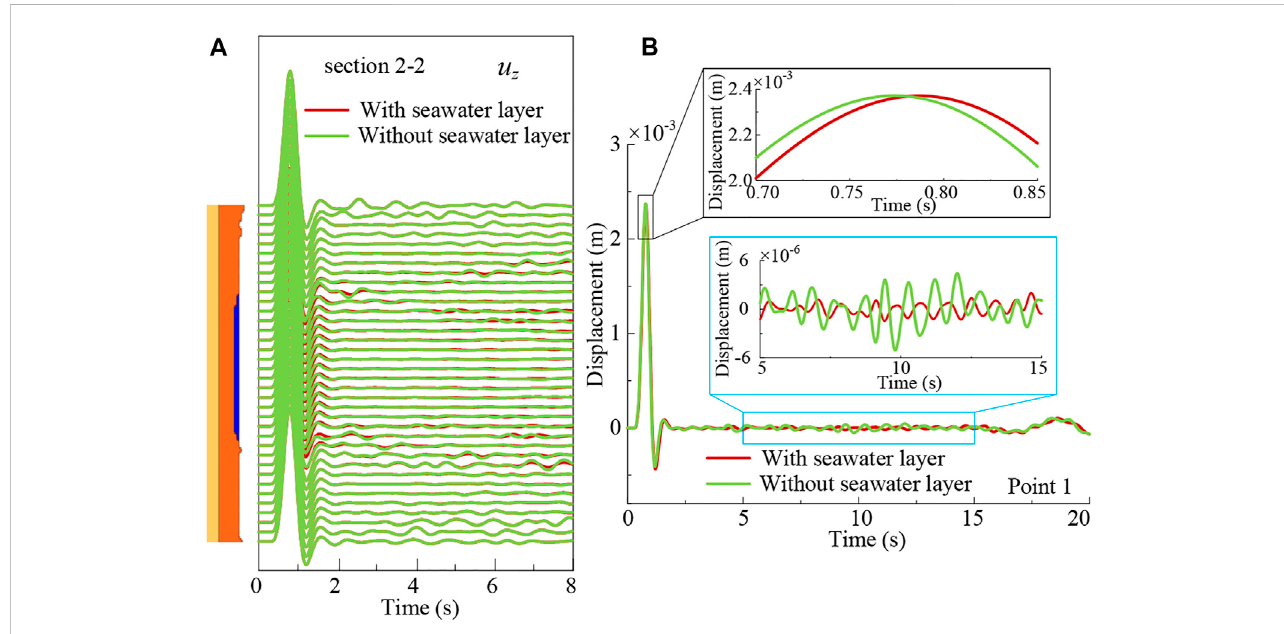
FIGURE 12 Comparison of the cases with and without sea water layer: (A) Displacement waveforms along the top of bedrock layer of cross section 2-2; (B) Displacement time history of point